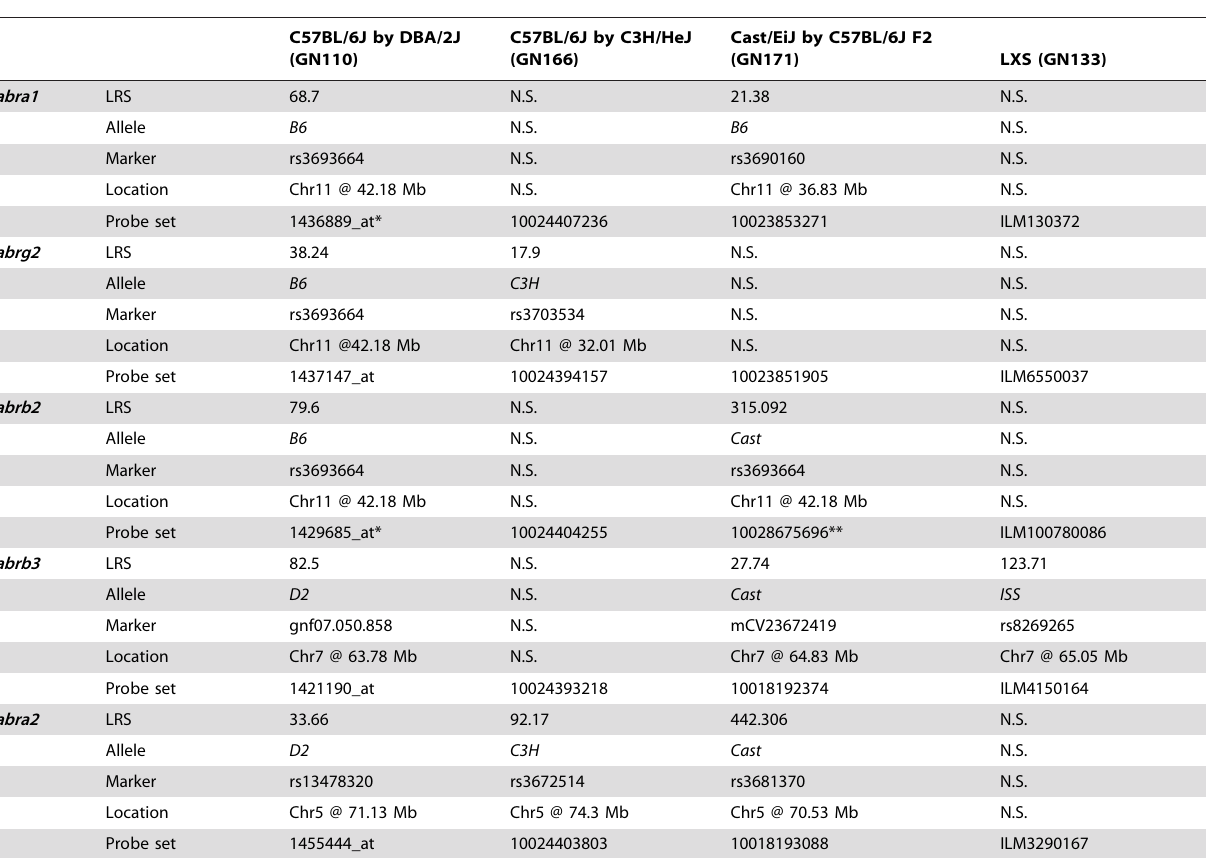
Table 2. Summary of GABA(A)R subunit cis modulation among several genetic